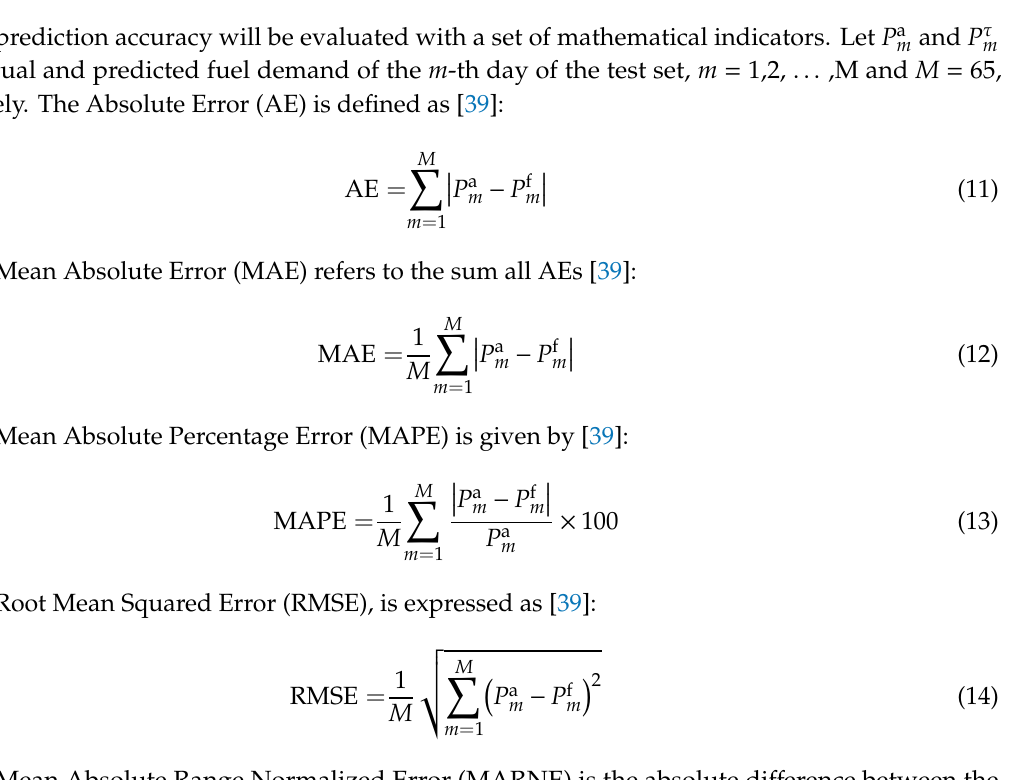
Figure 8. Fuel consumption time series.